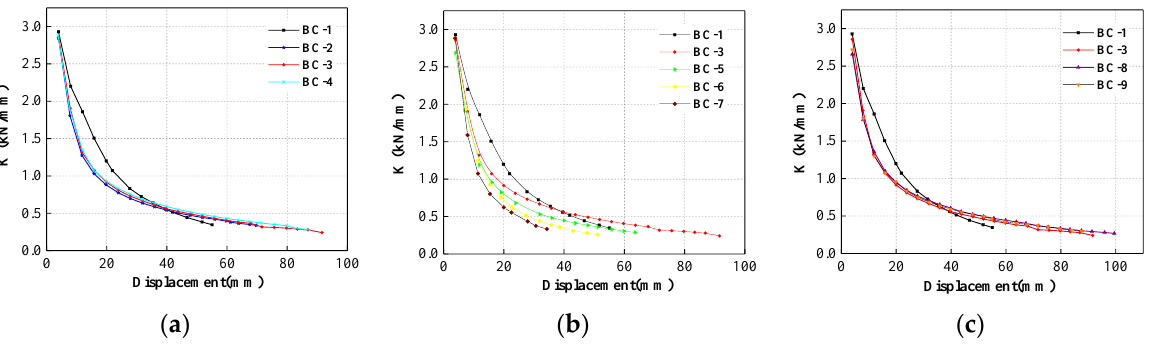
Figure 11. Stiffness degradation of joint specimens. ( a ) Stirrup ratio group; ( b ) Axial pressure ratio group; ( c ) Concrete strength group.